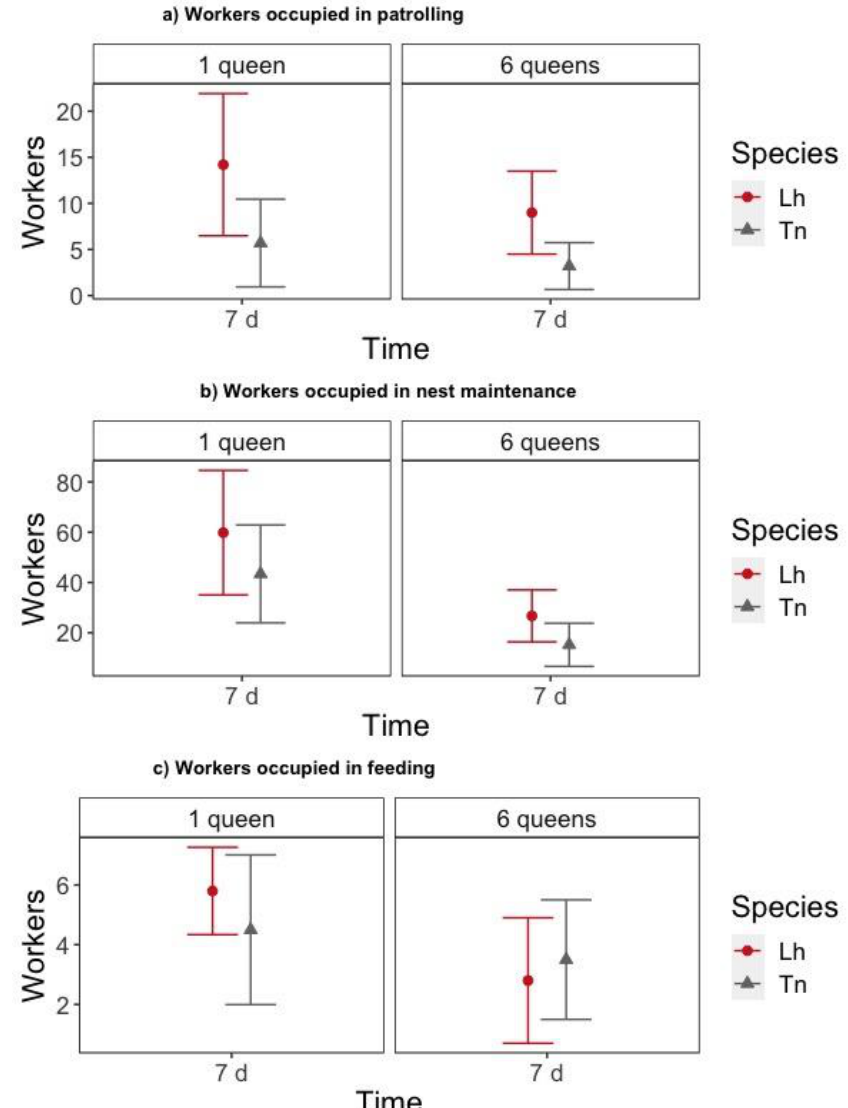
Figure 4. Number of workers (mean ± 95% Confidence Interval (CI)) outside the nest 7 days after placing them in the foraging arena according to the species (Lh = L. humile and Tn = T. nigerrimum ) and the number of queens placed in the colony: ( a ) workers occupied in patrolling, ( b ) workers occupied in nest maintenance and ( c ) workers occupied in feeding.